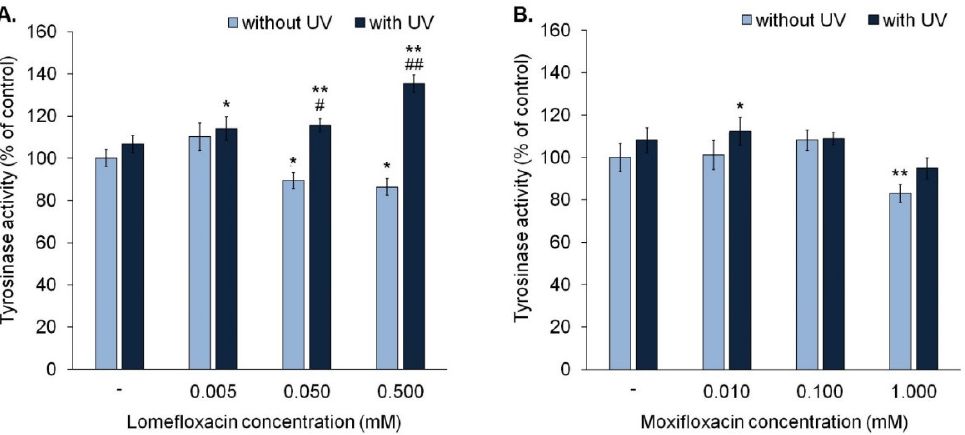
Figure 5. Lomefloxacin magnifies the effect of UVA radiation (1.3 J/cm 2 ) on tyrosinase activity. The